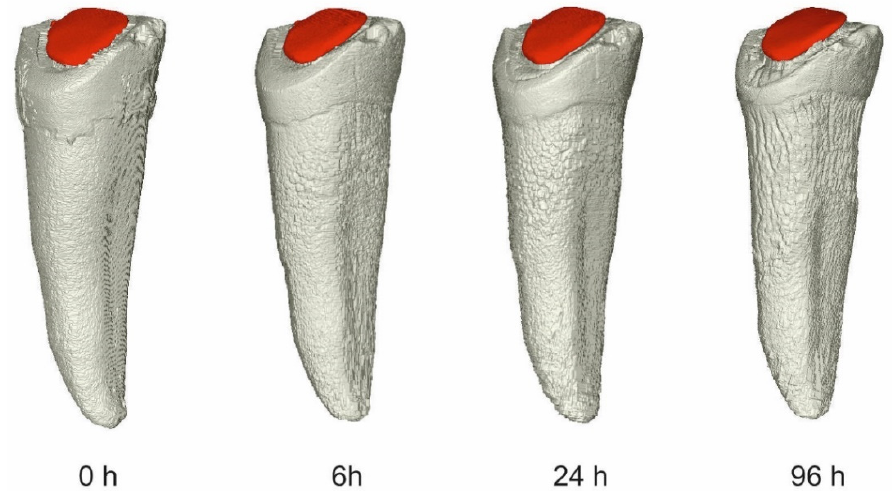
Figure 8. There were four micro-CT scans made for each sample, and each scan was segmented into three parts: bone, tooth, and in the case of the treated tooth, also with the dental material part. This picture shows a dental filling with composite resin on tooth 34 from the segment labeled “33” after exposure to 75% sulfuric acid after various times of exposure. It is obvious the composite filling is not losing volume in the acid bath, in contrast to the remaining tooth structures.